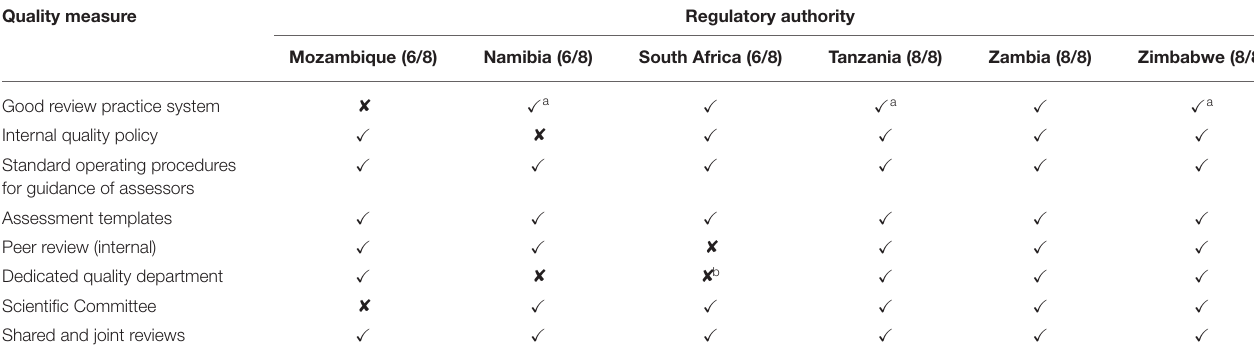
TABLE 3 | Comparison of the quality measures implemented by the six regulatory authorities.